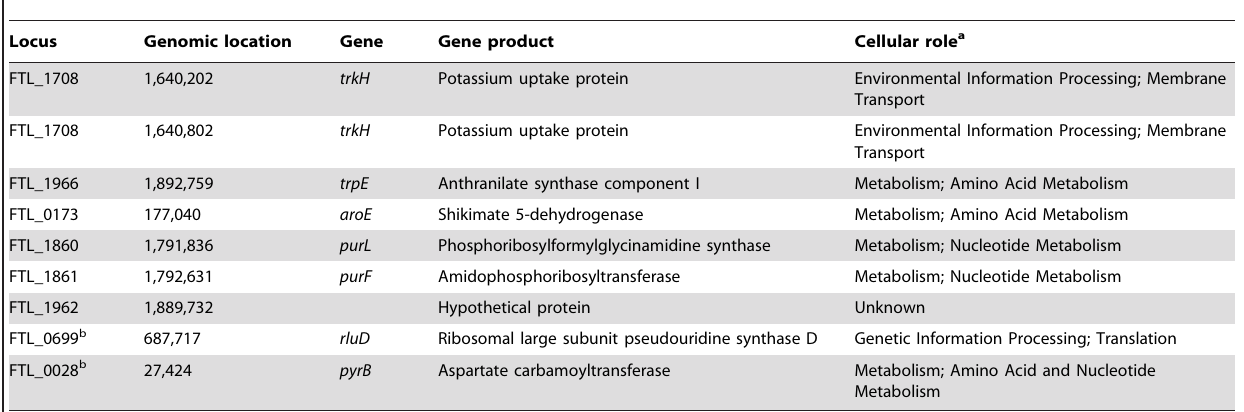
Table 1. Summary of mutants identified in